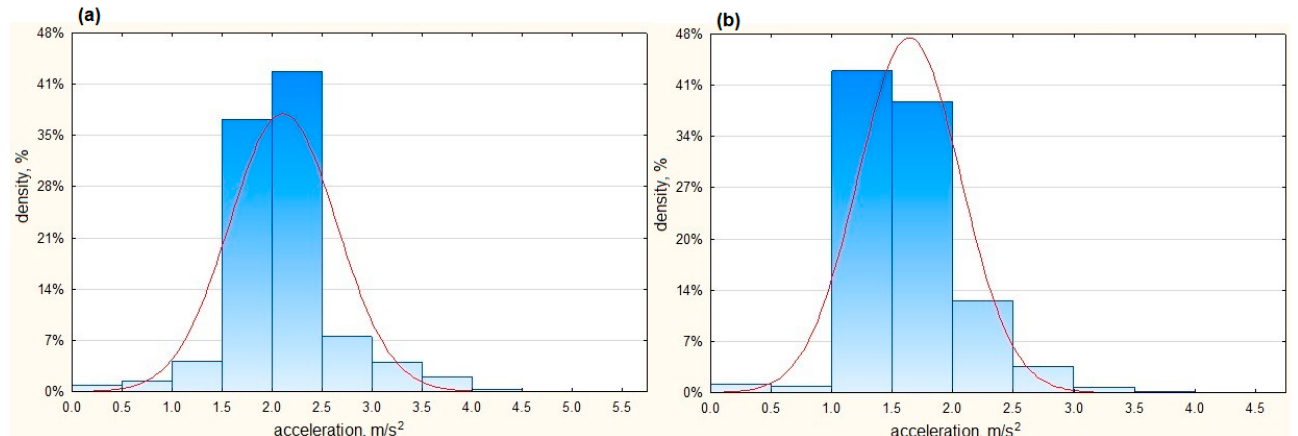
Figure 11. Acceleration recorded in real traffic conditions ( a ) for an urban bus and ( b ) for a coach.